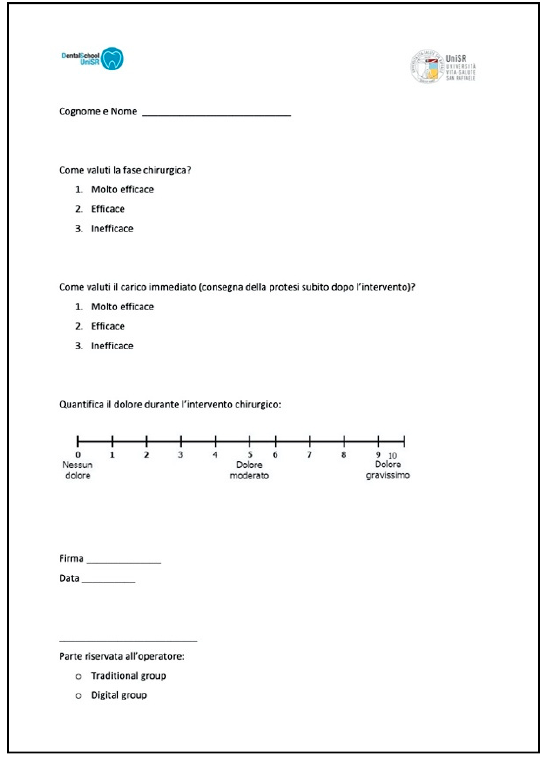
Figure A2. Questionnaire 2.